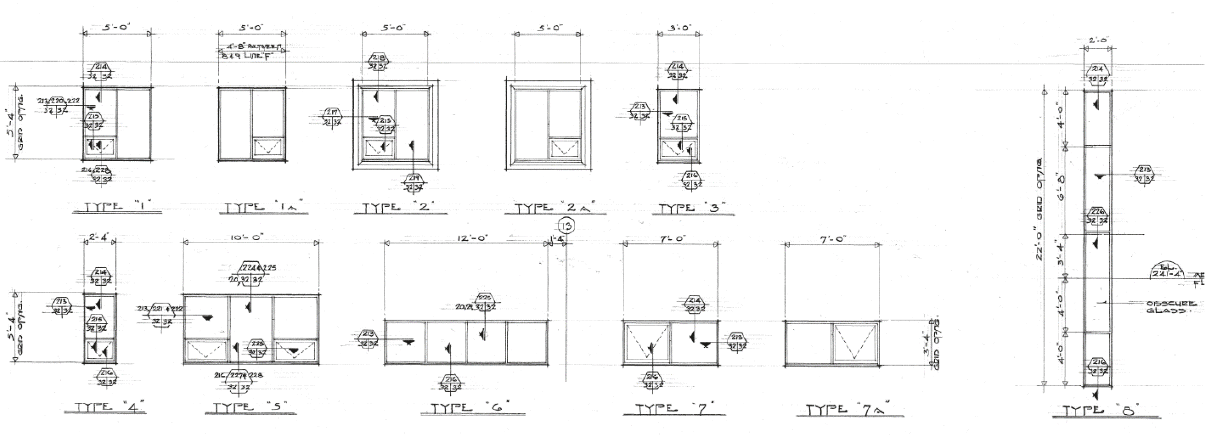
Figure 4: Details of windows used in the Carew